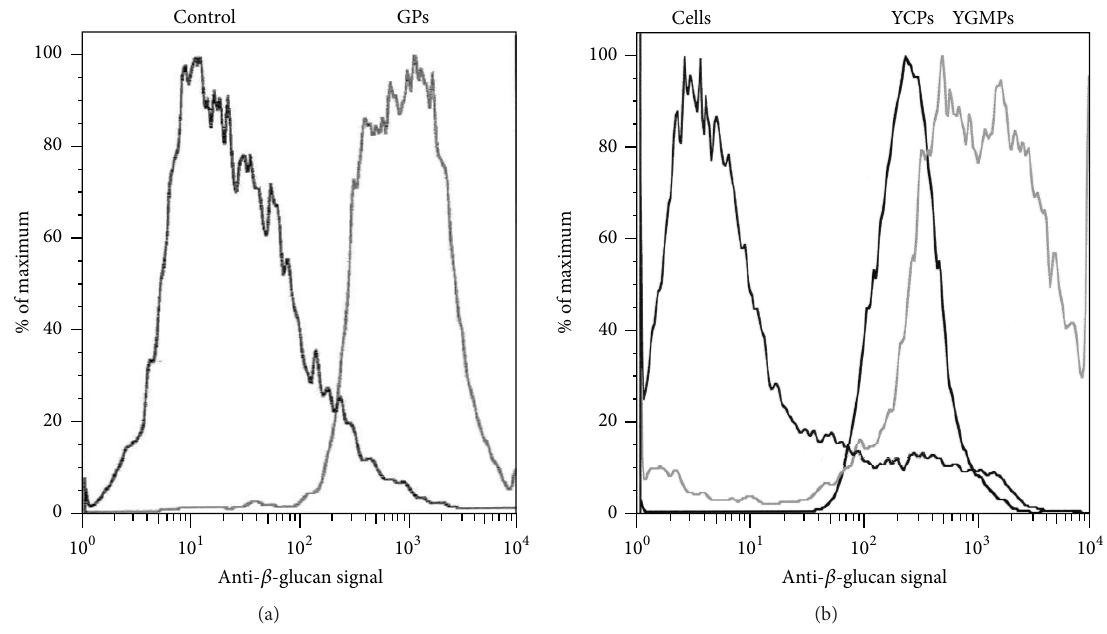
Figure 8: Anti- 𝛽 -1,3-D-glucan binding (FACS).(a) Bindingto GPs defines MFI(mean fluorescence intensity) ofpureglucan. Control , binding to GPs using secondary antibody only. (b) Cells , untreated PAP1502 cells. YCPs , binding to pH 11.9 VP1-GFP YCPs. YGMPs , cell wall particles from which most mannan has been